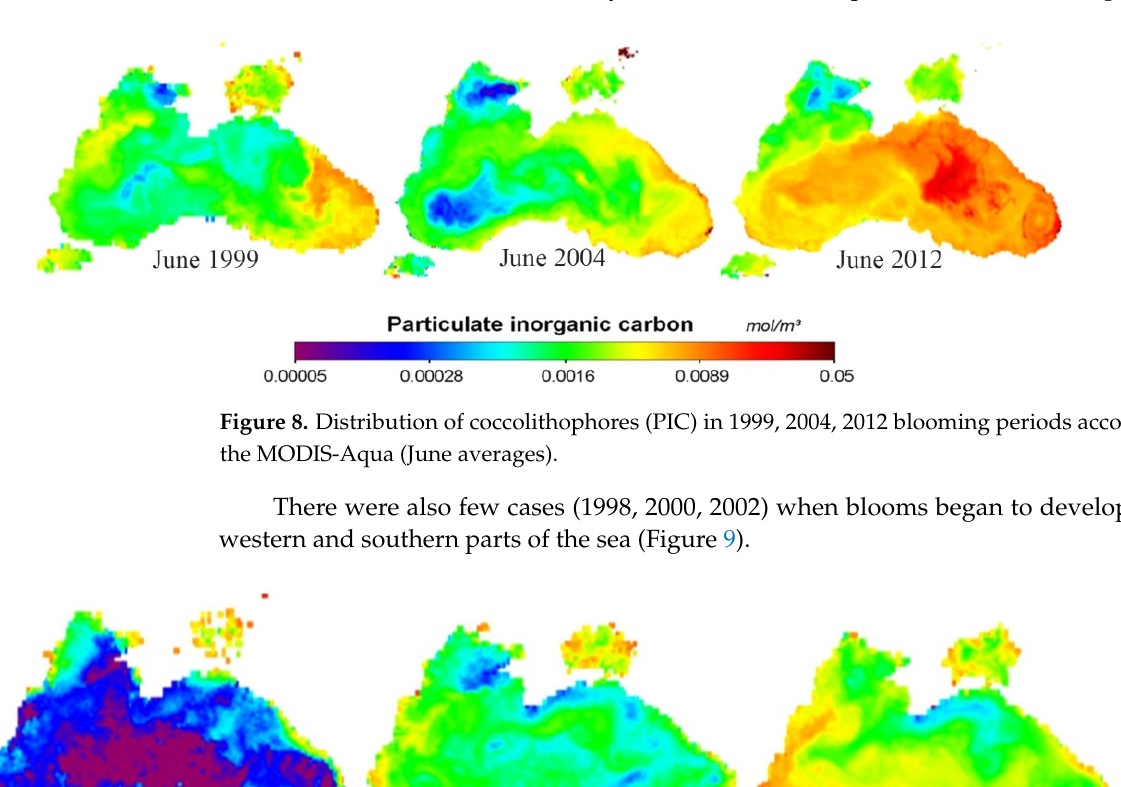
Figure 7. Chlorophyll distribution in the Caspian Sea in June, July and August 2001 according to Modis-Aqua.